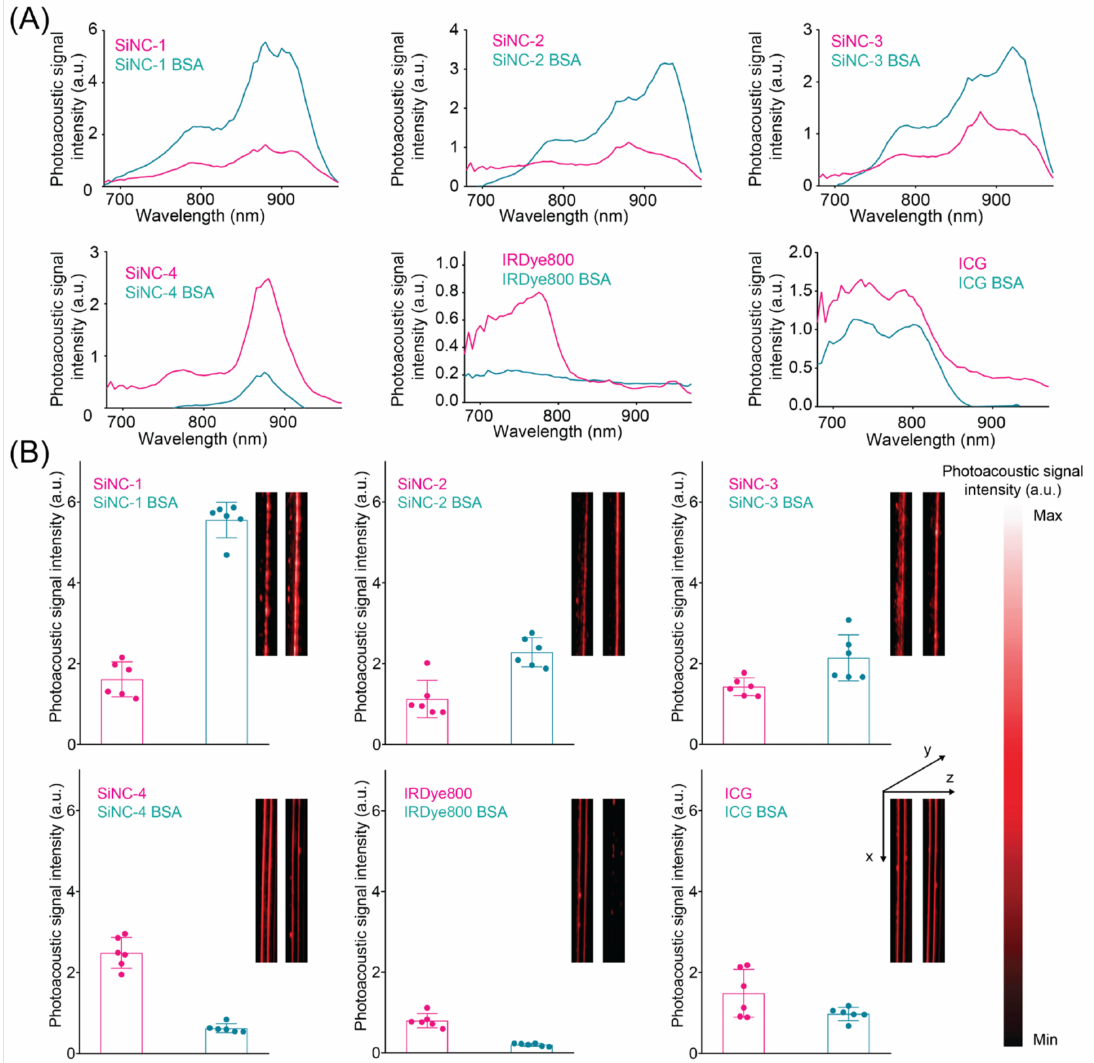
Figure 4. ( A ) Photoacoustic spectra of silicon naphthalocyanine dyes (SiNC-1–4), IRDye800 and ICG recorded in PBS with (magenta) and without 0.1% BSA (cyan). ( B ) PA signal intensity of SiNC1–4, IRDye800 and ICG recorded at 880 nm, 775 nm, and 780 nm wavelength illumination, respectively, in the presence and absence of BSA. Inset shows the PA image. Imaging orientation is provided in the inset for ICG/ICG BSA. Photoacoustic signal intensity (a.u.) bar is provided in the